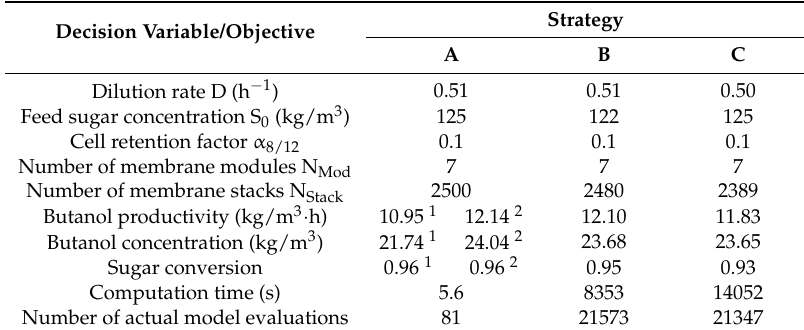
Table 3. Decision variables and objectives of best solutions of Pareto domains with a population of 5000 individuals obtained with strategies A, B and C (see Figure